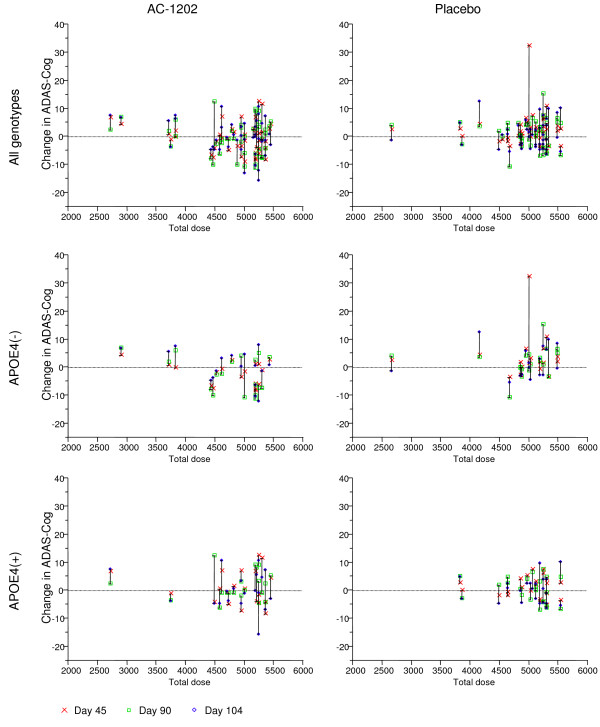
Plot of change in ADAS-Cog and total dose administered for each of the per protocol participants. Y axis is change in ADAS-Cog score from Baseline. X axis is total dose in grams. Each subject is represented by three symbols. A red x represents the change from Baseline score at Day 45. A green square represents the change from Baseline at Day 90. A blue diamond represents the change from Baseline at Day 104. APOE4(-) subjects who received more than 4000 grams generally improved in ADAS-Cog score.